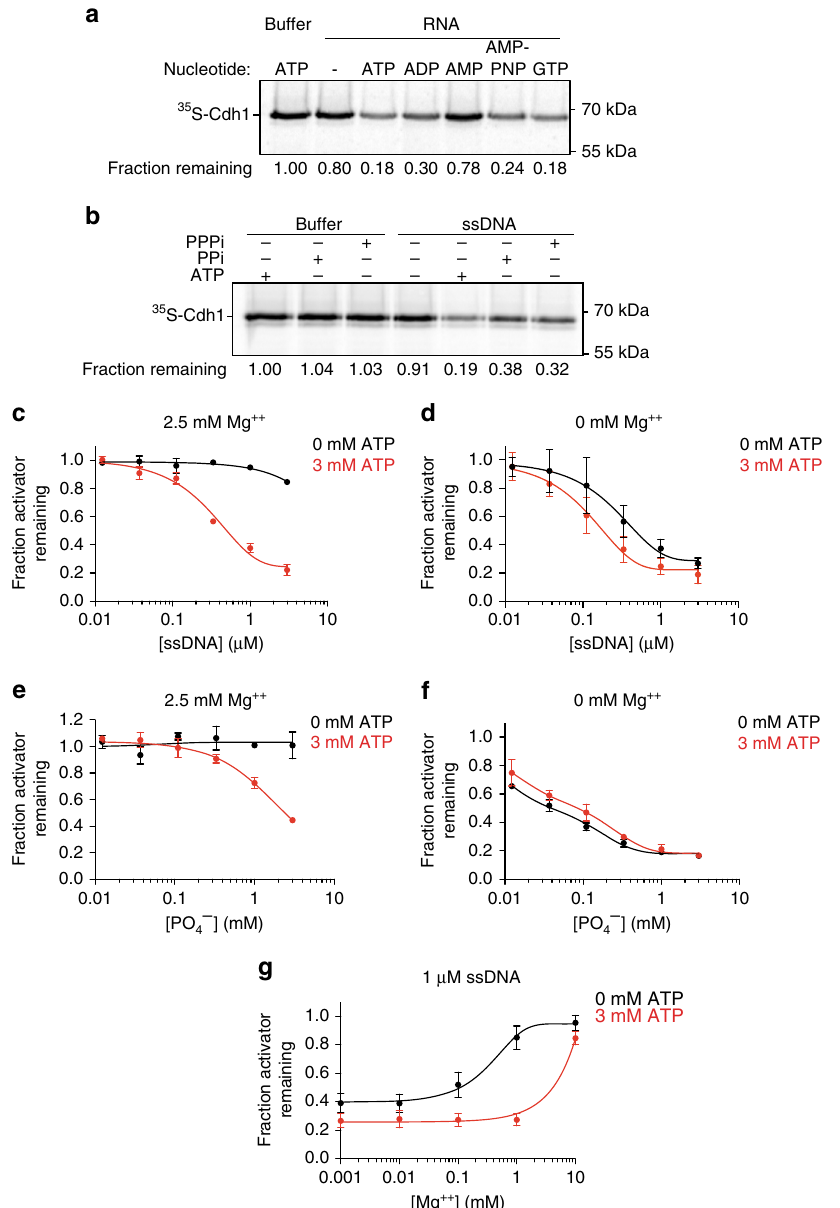
Fig. 4 ATP promotes activator dissociation by sequestering magnesium ions. a The effect of the indicated nucleotides on Cdh1 dissociation was tested using phenol – chloroform extracted RNA species from the hydroxyapatite fl ow-through fraction (Fig. 2b). Reactions were supplemented with 2.5 mM MgCl 2 and 3 mM of the indicated nucleotides. Uncropped autoradiograph and source data are provided in the Source Data fi le. b 3 mM ATP, inorganic pyrophosphate (PPi), or tri-phosphate (PPPi) were tested in a Cdh1-dissociation assay with reaction buffer or 1 μ M 75mer ssDNA oligonucleotide. Reactions contain 2.5 mM MgCl 2 . Uncropped autoradiograph and source data are provided in the Source Data fi le. c – f A 75mer ssDNA oligonucleotide c , d or polyphosphate e , f was tested in the Cdh1-dissociation assay in the presence c , e or absence d , f of 2.5 mM MgCl 2 . Reactions were supplemented with 0 mM (black) or 3 mM ATP (red). Data indicate means (±SEM) from two independent experiments. Uncropped autoradiographs and source data are provided in the Source Data fi le. g The inhibitory effect of various MgCl 2 concentrations was analyzed in Cdh1-dissociation reactions. Reactions were performed using 1 μ M 75mer ssDNA with (red) or without (black) 3 mM ATP. Data indicate means (±SEM) from two independent experiments. Uncropped autoradiographs and source data are provided in the Source Data fi